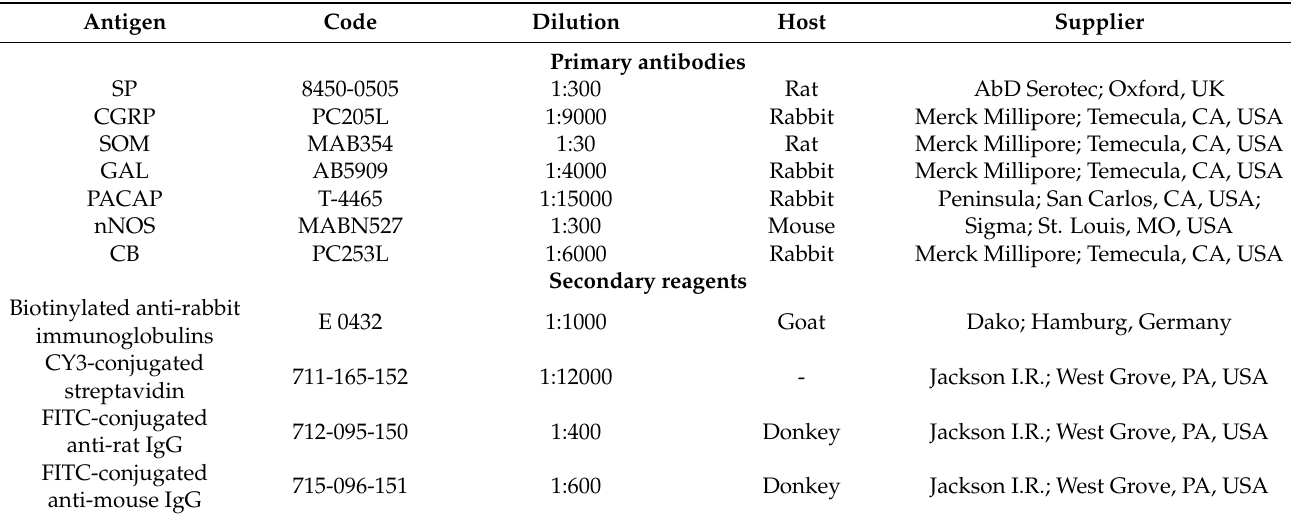
Table 3. List of primary antisera and secondary reagents used in this